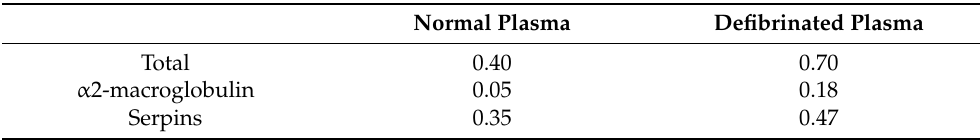
Table 1. Decay constants of thrombin in normal and defibrinated plasma using thrombin generation with an added substrate where both the clot and fluid compartment are measured. From